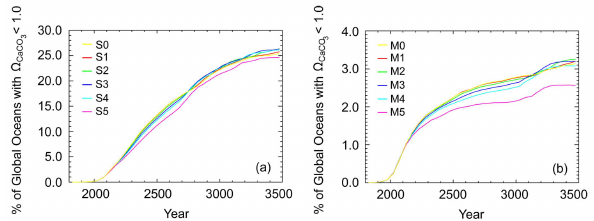
Fig. 9. Plot of the change in the percent of global oceans under- saturated with respect to calcite relative to preindustrial times un- der (a) a “business-as-usual” CO 2 emissions scenario (Suite S) and (b) under a “mitigation” CO 2 emissions scenario (Suite